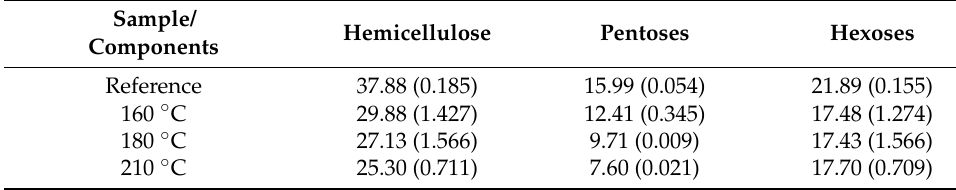
Table 5. Hemicelluloses (in mass % of oven dried samples).